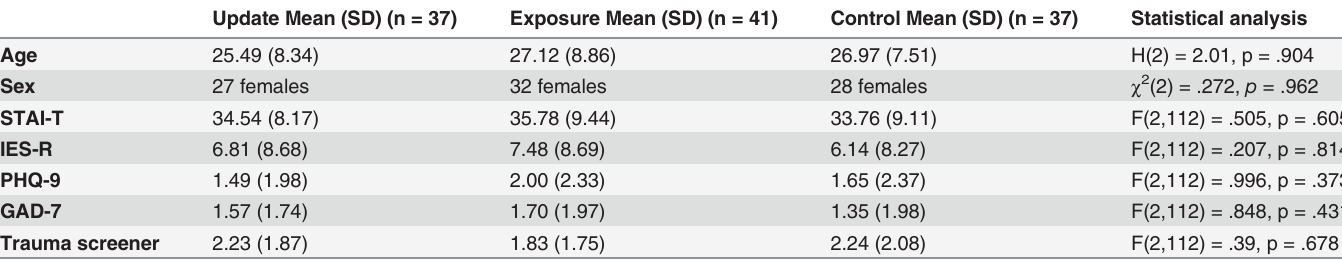
Table 1. Baseline measures.